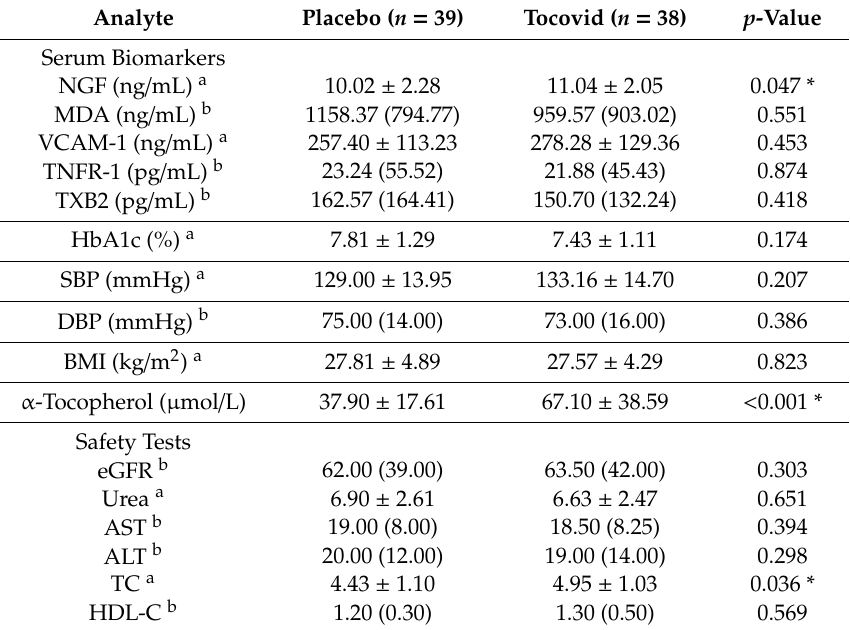
Table 4. End of eight weeks comparison of analytes between Tocovid and placebo groups.